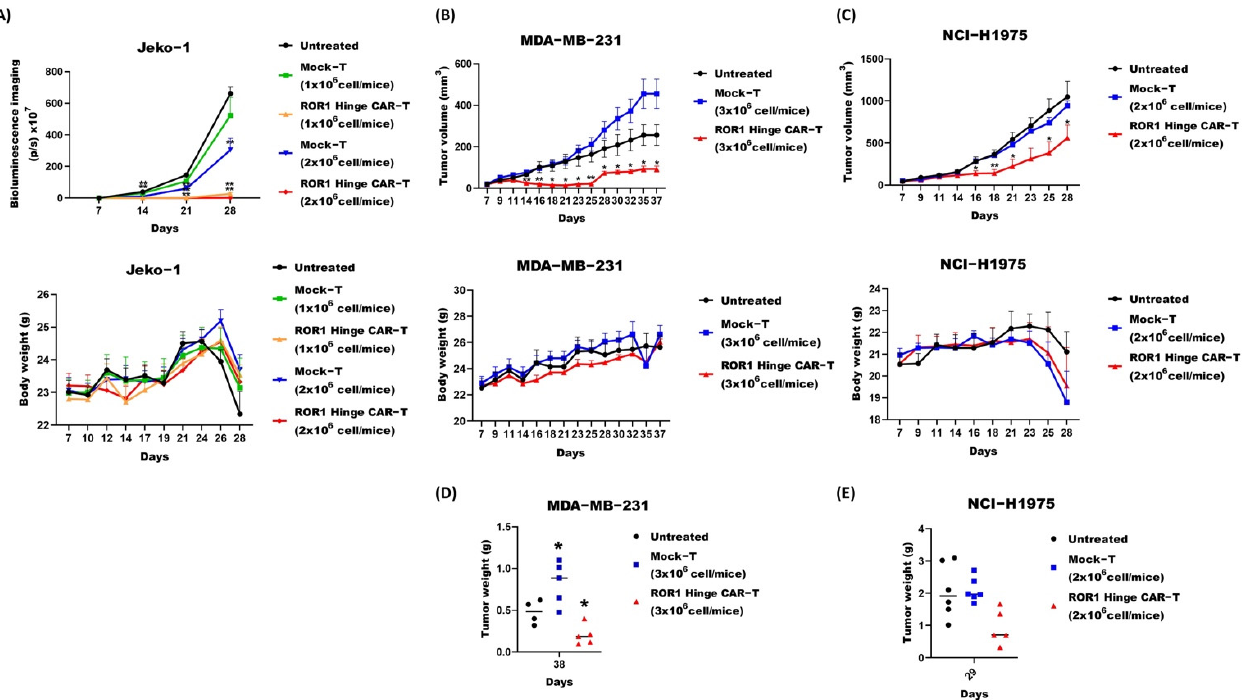
Figure 4. ROR1 Hinge CAR-T-cells suppressed solid tumor growth and posed no obvious side effects in vivo. ( A ) Jeko-1 animal model, the NSG mice that received 1 × 10 6 Jeko-1 that was transduced with luciferase construct intravenously. At day 7, the mice received a single dose of different numbers of Mock-T or ROR1 Hinge CAR-T-cells. Bioluminescence ( Top ) was measured once a week, whereas body weight ( Bottom ) was measured at designated dates (n = 5 or 6, * p < 0.05, ** p < 0.01); ( B ) MDA-MB231 animal model, the NSG mice received 1 × 10 6 MDA-MB-231 cells subcutaneously at one side. At day 3, the mice were treated with a single dose of Mock-T or ROR1 Hinge CAR-T-cells at the designated numbers. Tumor volumes ( Top ) were measured over time (n = 5 or 6, * p < 0.05, ** p < 0.01), whereas body weight ( Bottom ) was measured at designated dates; ( C ) NIH-H1975 animal model, the NSG mice received 1 × 10 6 NIH-H1975 cells subcutaneously at one side. At day 3, the mice were treated with a single dose of Mock-T or ROR1 Hinge CAR-T-cells at the designated numbers. The tumor volumes ( Top ) were measured over time (n = 5 or 6, * p < 0.05, ** p < 0.01), whereas body weight ( Bottom ) was measured at designated dates; ( D ) Mice bearing MDA-MB-231 tumor were sacrificed at day 38, the tumors were extracted and weighed (n = 5 or 6, * p < 0.05, ** p < 0.01); ( E ) The mice bearing NIH-H1975 tumor were sacrificed at day 29 when the tumors were extracted and weighed (n = 5 or 6, * p < 0.05, ** p <